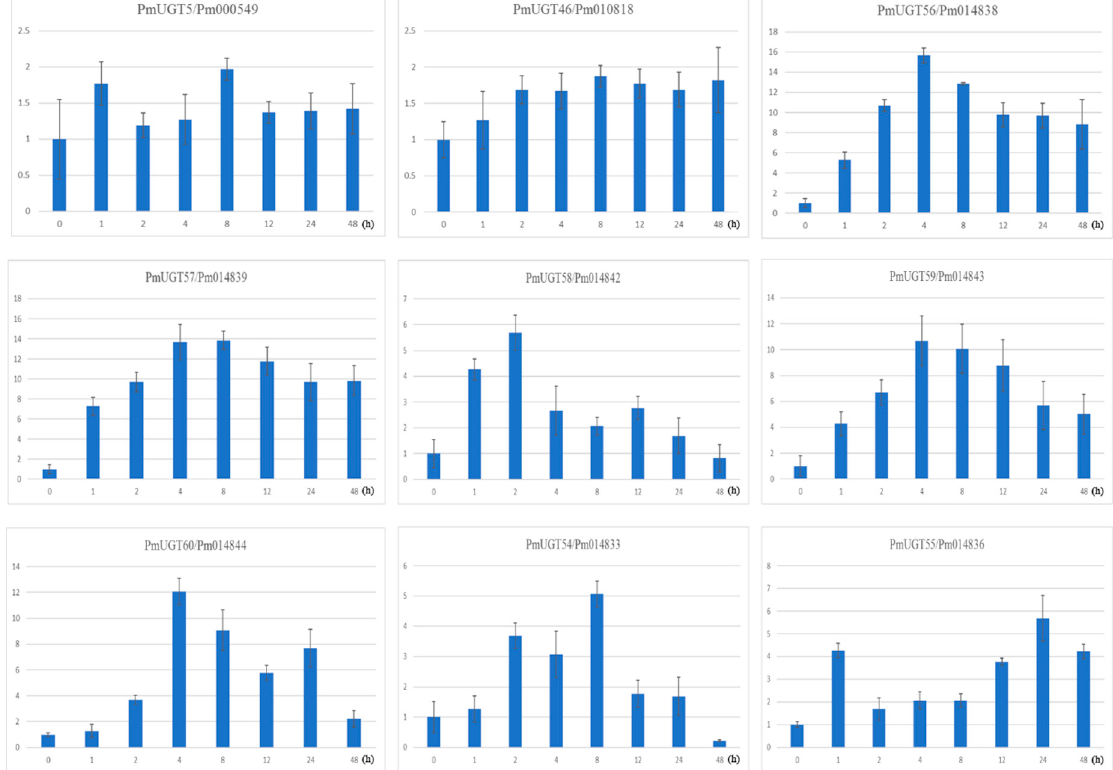
Figure 7. Expression patterns of PmUGTs in response to ABA treatment. The relative expression level of nine group E genes was examined by the RT-qPCR and normalized with the reference gene PP2A. Relative expression of 9 genes under ABA treatment at 0, 1, 2, 4, 8, 12, 24 and 48 h. The error bars represent standard deviations, y -axis are scales of relative expression level and x -axis are the time course (h) of ABA treatment.